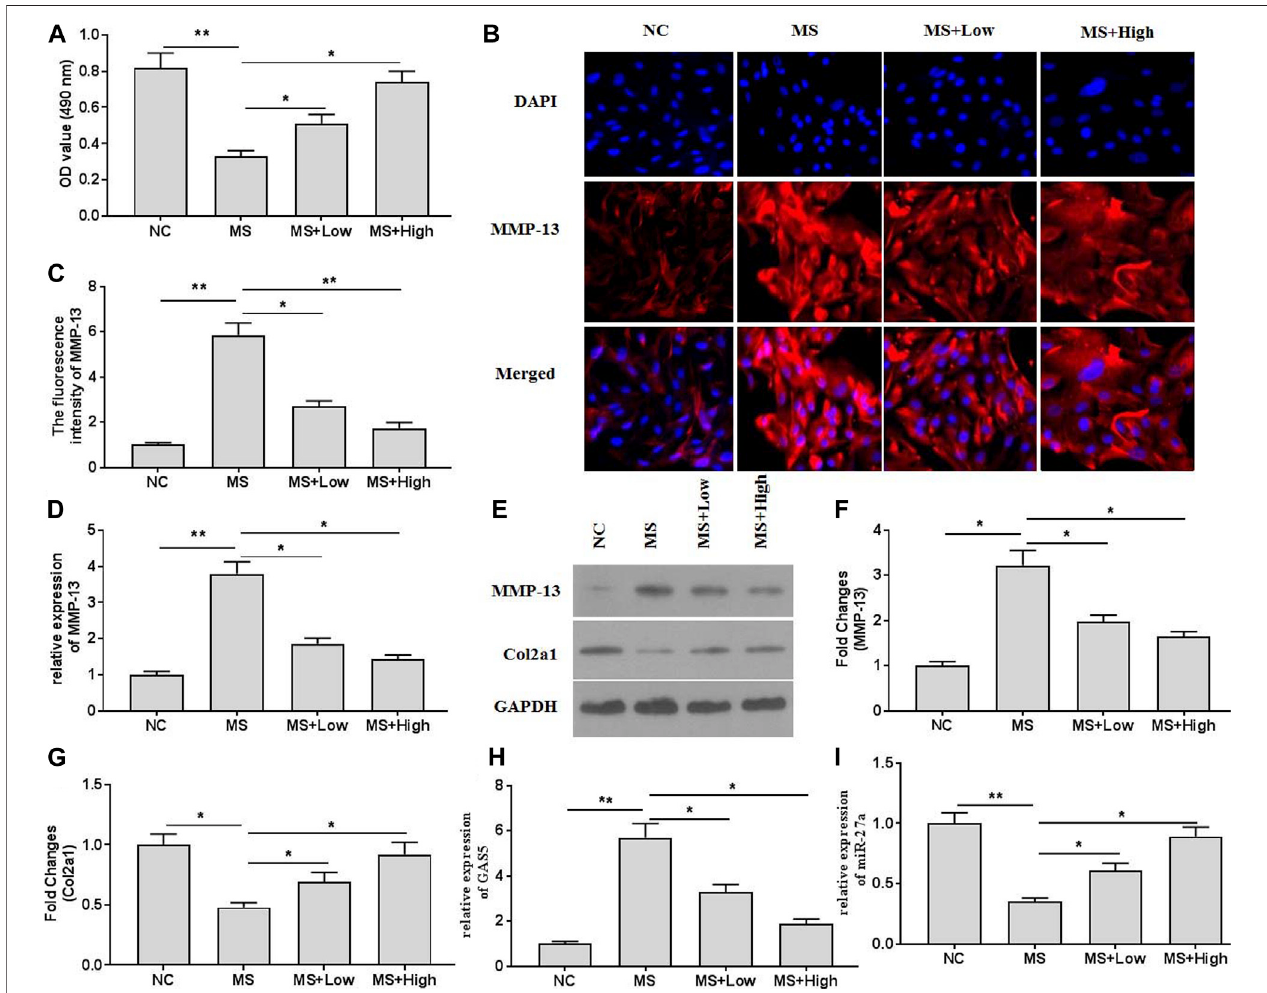
FIGURE 2 | The effects ofXH on mechanical stimulation-induced MMP-13 and GAS5/miR-27a expression in chondrocytes were investigated. (A) The cell viability wasdetermined byCCK-8assays. (B) Theimmuno fl uorescenceintensityofMMP-13inmechanicalstimulation-treatedchondrocyteswasdetected. (C) Thecalculation of fl uorescence activity of MMP-13. The mRNA (D) expression of MMP-13 was determined by qRT-PCR, and the protein expression of MMP-13 (E-F) and Col2a1 (E , and G) were determined by western blotting assays. The expression of GAS5 (H) and miR-27a (I) was detected by qRT-PCR. * p < 0.05 and ** p < 0.01. NC, negative control; MS, mechanical stimulation; Low, XH (5 μ M); High, XH (20 μ M).